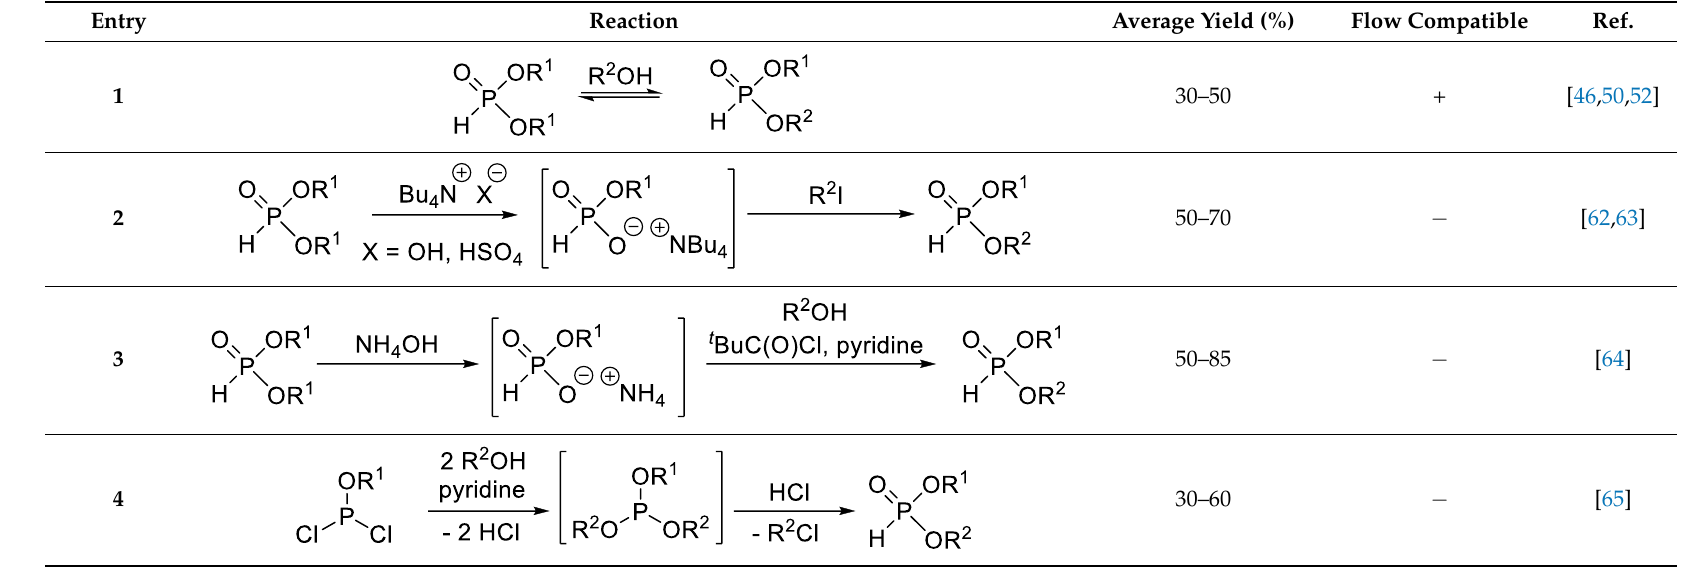
Table 1. Synthetic methods for the preparation of dialkyl H -phosphonates bearing two different alkyl groups.